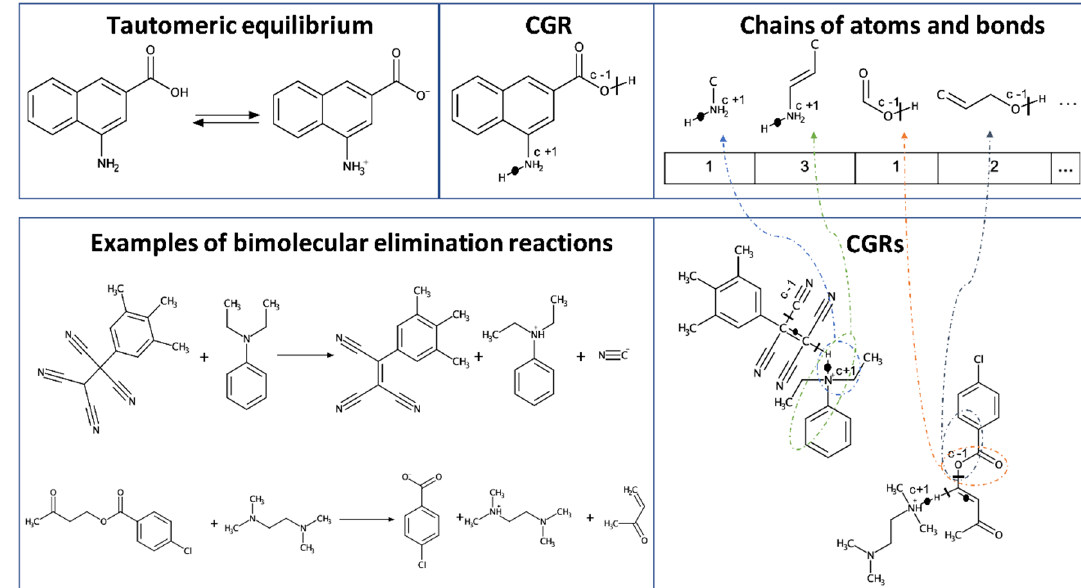
Figure 3. Fragment Control considers tautomerization reactions (presented at the top) as belonging to the AD defined for the E2 reactions (bottom) because all fragments of the CGRs of tautomerization reactions (top right) are present in the CGRs of the reactions contained in the E2 dataset. CGRs are shown to the right of the corresponding reaction .